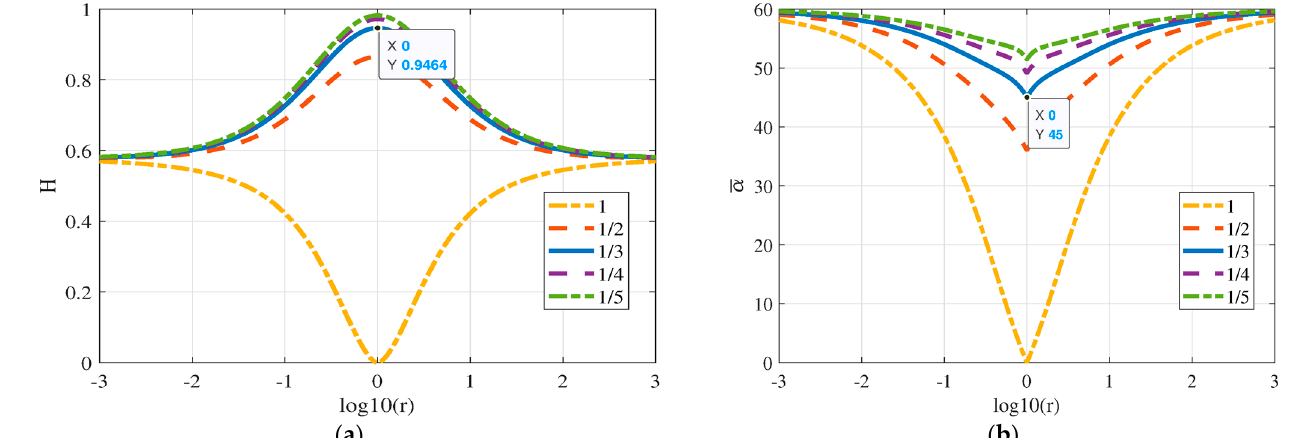
Figure 1. Polarization characteristics of GVSM. ( a ) H of GVSM with different 𝑝 ; ( b ) α of GVSM with different 𝑝 .